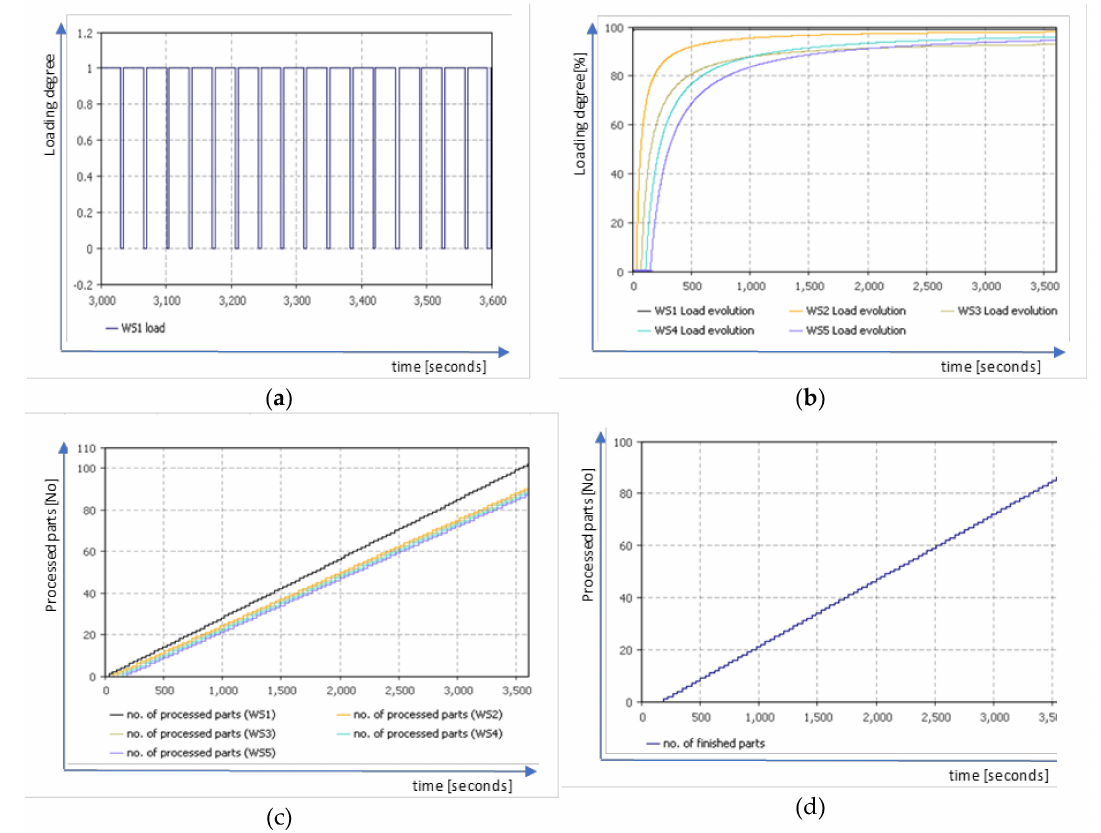
Figure 7. Simulation results of target situation: ( a ) Loading degree (per workstation); ( b ) Loading degree per all the workstations; ( c ) Evolution of the number of processed parts; ( d ) Evolution of the finished